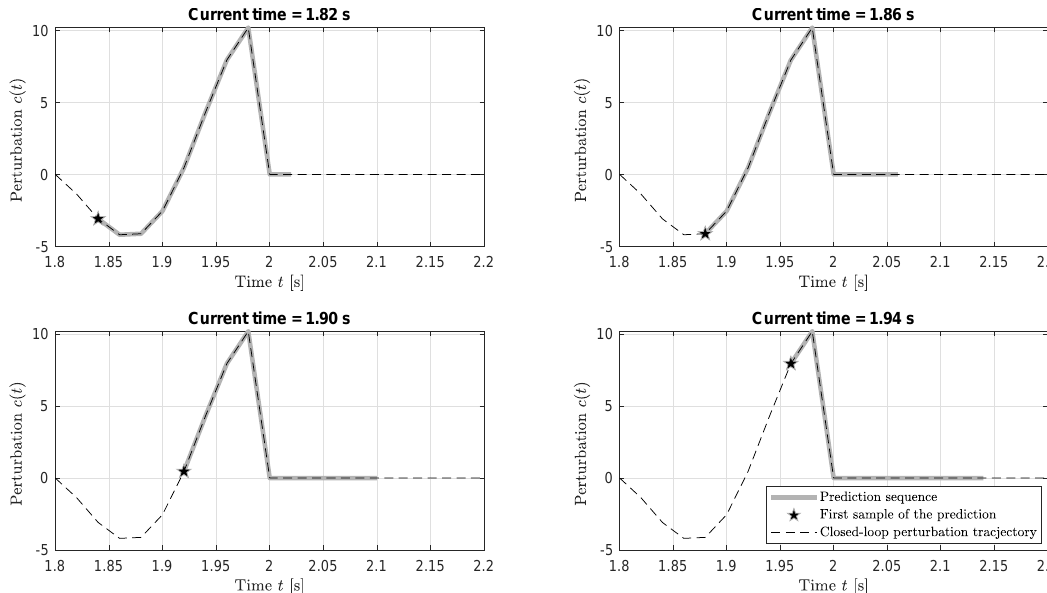
Figure 3. Time-series of predictions and closed-loop trajectory of the perturbation input. Four diagrams at a different time, showing that the predicted perturbation sequence (grey solid line) is consistent with the actual input trajectory (dash